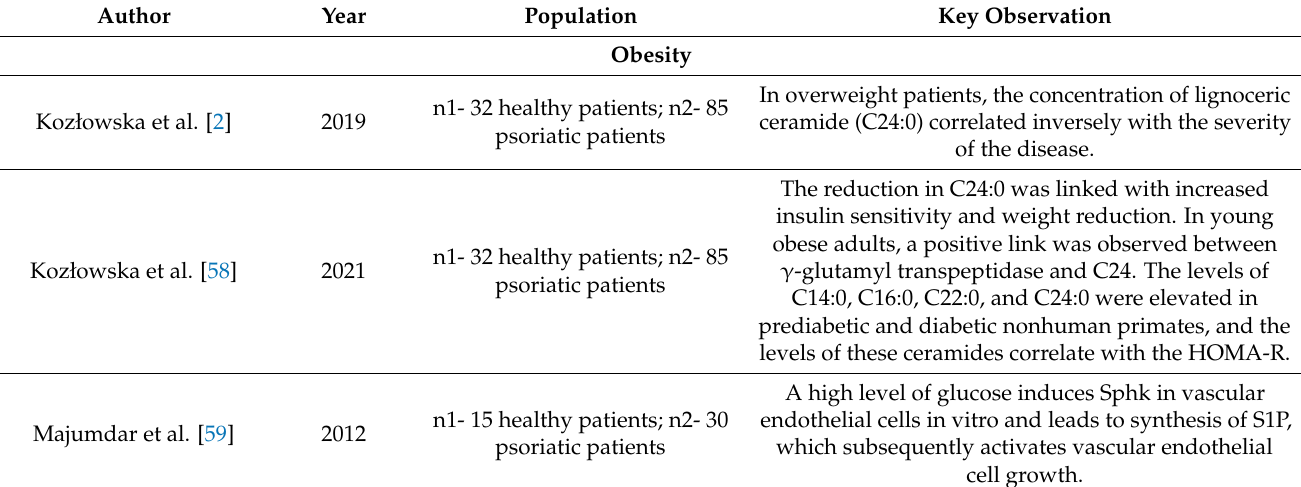
Table 5. Summary of the studies on sphingolipids in psoriasis and obesity and metabolic syndrome.